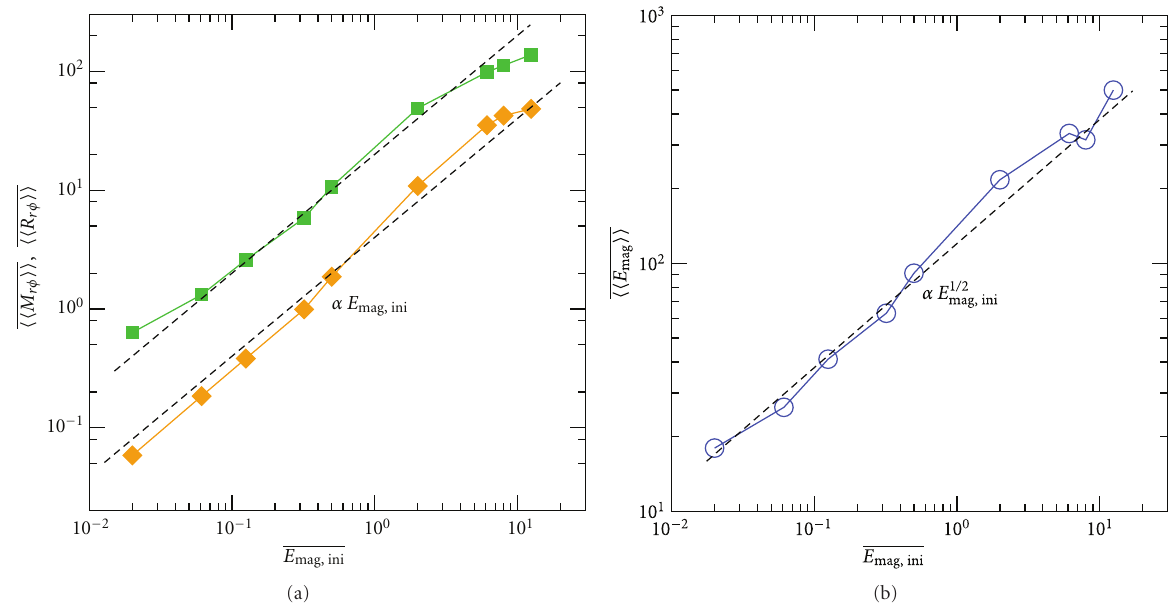
Figure 21: The dependence of the time- and volume-averaged (a) Maxwell (green squares) and Reynolds stresses (orange diamonds) and (b) magnetic energy (blue circles) and in the turbulent state on the strength of the initial magnetic energy E ini . Both the vertical and horizontal axes are normalized by the initial magnetic energy of the fiducial model E mag,0 . The initial field strength is varied from ∼ 10 11 to ∼ 6 × 10 12 G. and (b) E mag , respectively. We take the time-average of volume-averaged The dashed lines denote reference slopes proportional to (a) E 1 / 2 mag quantities during 90 t rot < t < 100 t rot